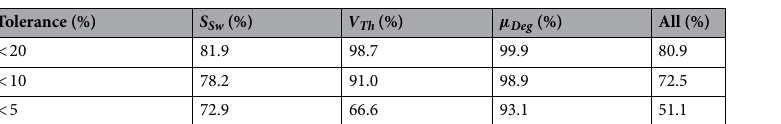
Table 3. Percentages of the design cases that meet the target specifications within specific relative tolerance. The tolerance is the allowed maximum ratio of the difference between the actual and target values over the target